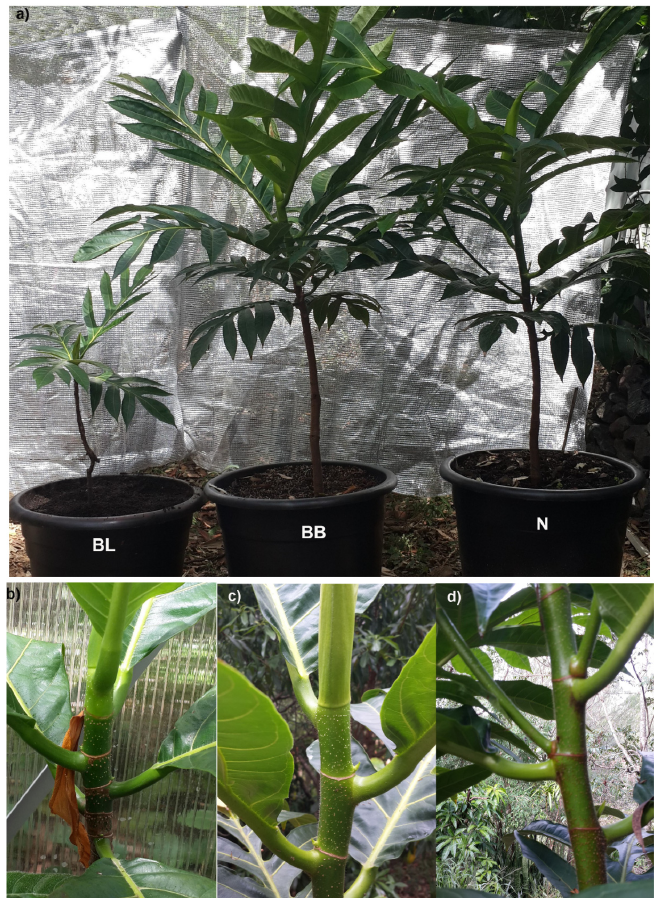
Figure 1. Representatives of breadfruit plants growing on different rootstocks. ( a ) Breadfruit plants growing on lakooch rootstocks (BL), self-graft (BB), and non-graft (N) at 21 months after grafting. ( b – d ) Breadfruit shoots showing internode length growing on lakoocha rootstocks ( b ), self-graft ( c ), and non-graft ( d ).